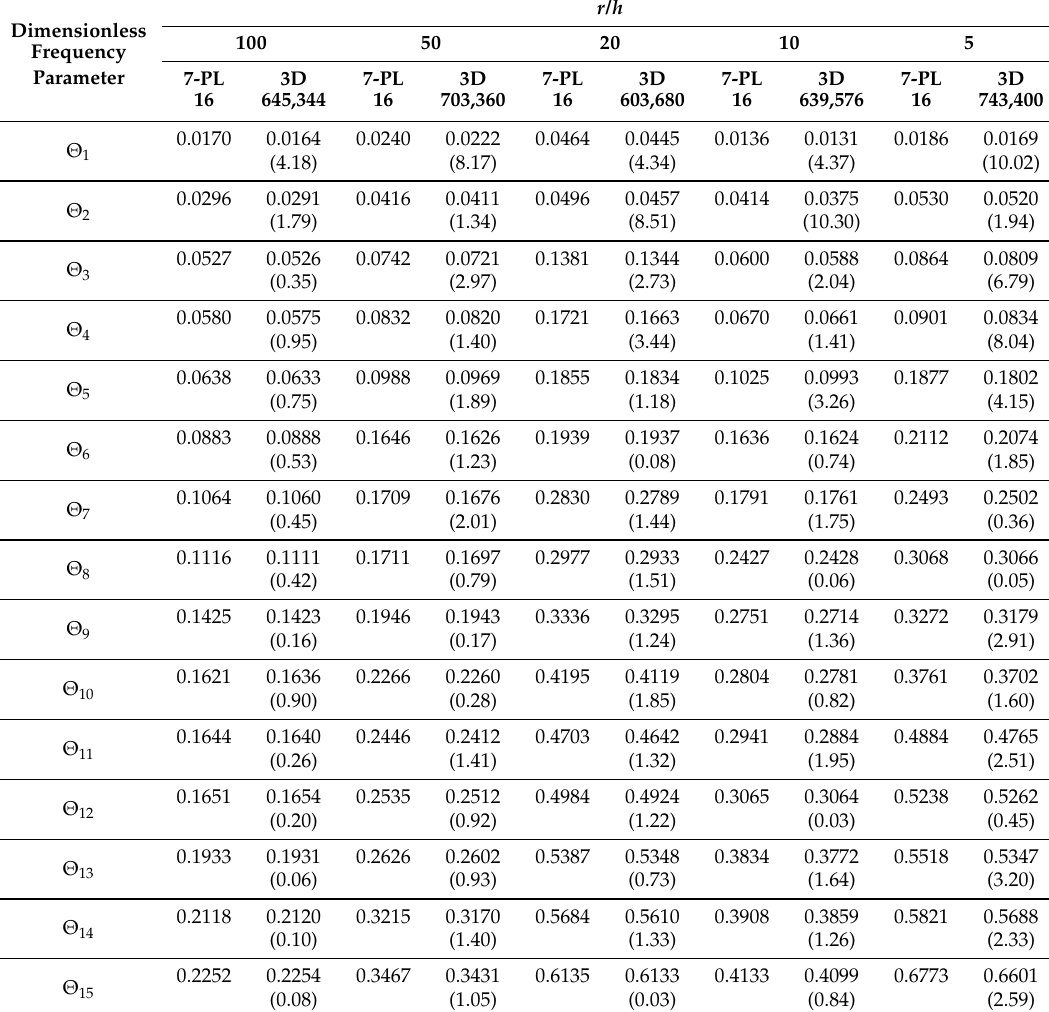
Table 20. Dimensionless parameter Θ for a quarter of cylinder with linear thickness variation. Dimensionless